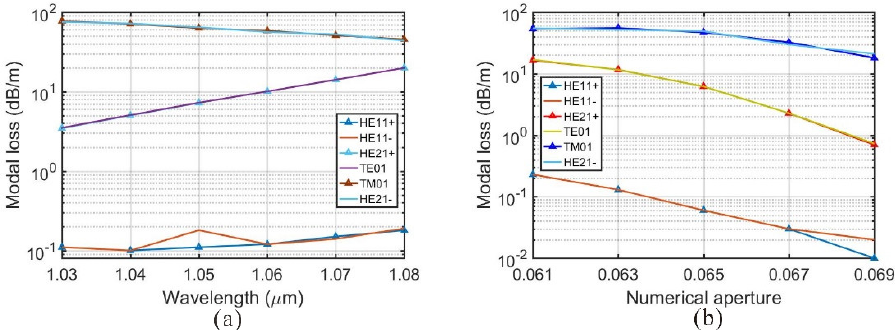
Figure 8. ( a ) Modal losses of a twisted heptagon-shaped core fiber versus wavelength with R = 25 μm, Λ = 4.5 mm, and NA = 0.063, λ in the range of 1.03–1.08 μm. ( b ) Modal losses of a twisted heptagon-shaped core fiber versus NA with R = 25 μm, Λ = 4.5 mm, and λ = 1064 nm, NA in the range of 0.061–0.069.